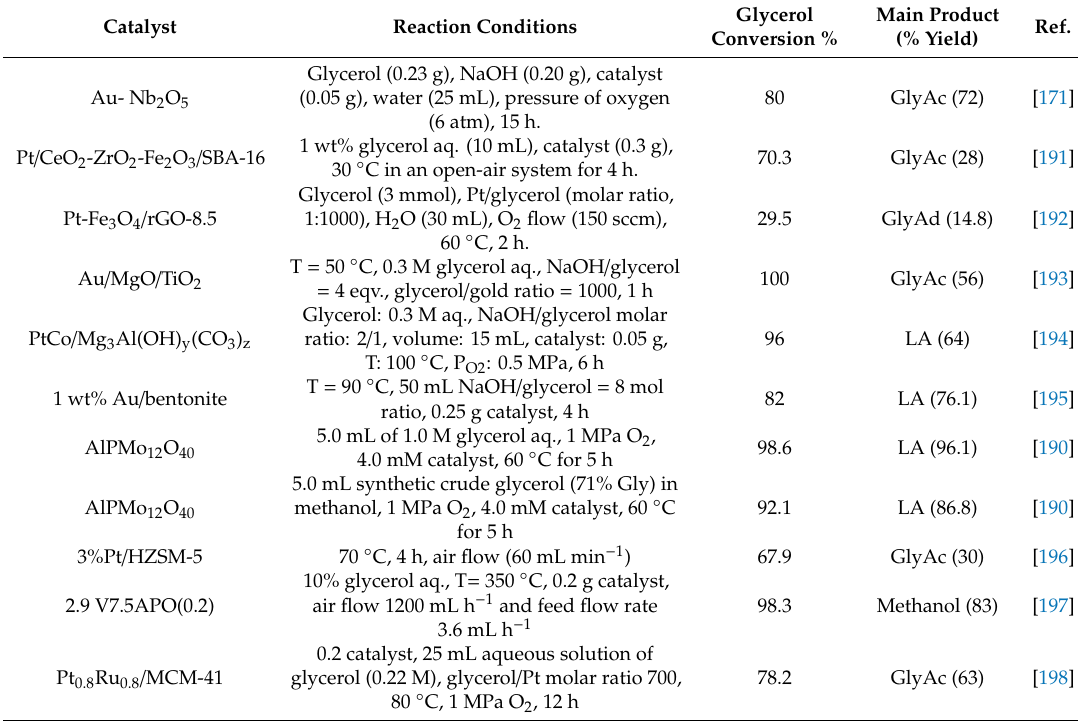
Table 6. Catalysts selected for glycerol